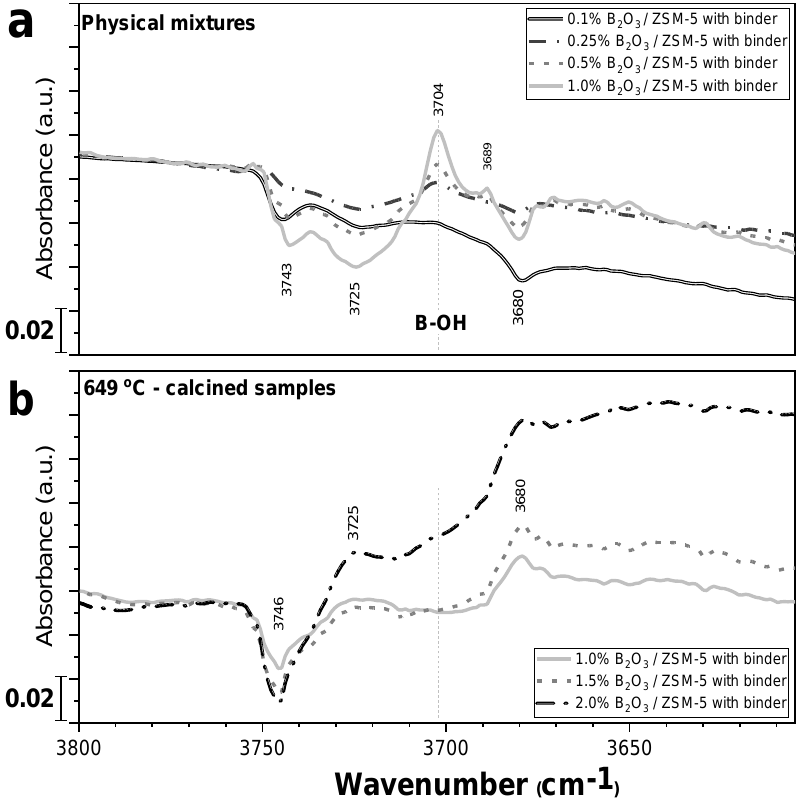
Figure 4. FTIR spectra in the OH region for ( a ) physical mixtures (Samples #5–8), and ( b ) 649 ◦ C—calcined boron trioxide with ZSM-5 (Samples